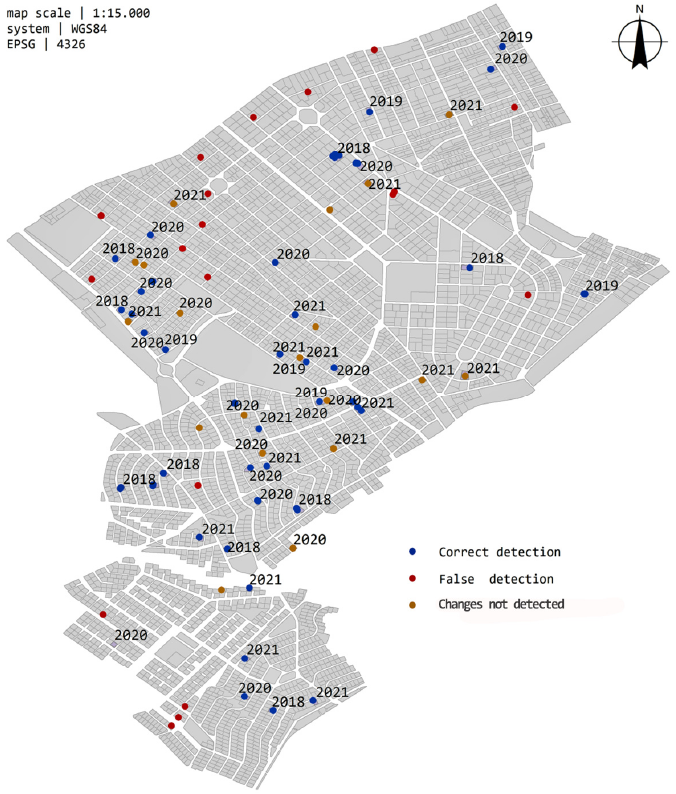
Figure 15. Visualization of detected PS points that may represent newly constructed buildings. Blue color corresponds to the correct detection of the method accompanied by date of construction, red corresponds to false detection and orange corresponds to real new buildings accompanied by date of construction that the method failed to detect.